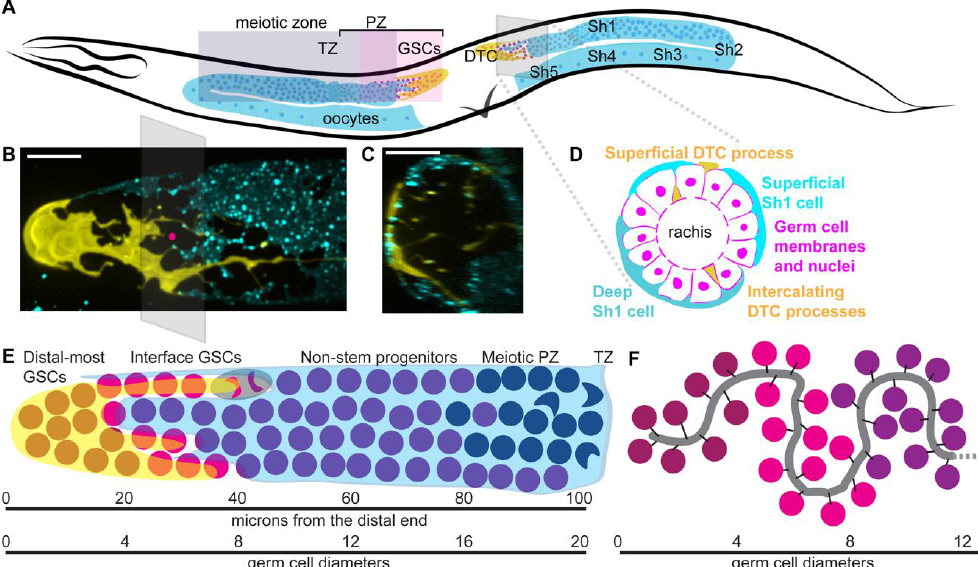
Figure 1. Structure and development of adult hermaphrodite gonad ( A ) Schematic of adult hermaphrodite gonad with distal tip cells (yellow, DTC), sheath cell pairs 1–5 (only superficial cell of each pair shown, cyan); somatic gonad cells are labeled in posterior gonad arm. In the anterior gonad arm, germ cell regionalization is shown in shaded boxes with the distal progenitor zone (PZ) containing germ stem cells (GSCs, pale pink), non-stem progenitor cells (bright pink) and cells in S phase of meiosis I (purple). The transition zone (TZ) is where crescent shaped nuclei of meiotic leptotene/zygotene stage are visible; this is a common visual landmark that can be detected with DAPI staining and does not rely on genetic markers. All meiotic germ cells shaded purple. Oocytes shown in proximal gonad. All germ cell nuclei are magenta. Head to left, dorsal up, vulva (V) at bottom. Gray pane shows angle of cross section shown in ( B ). ( B ) Confocal Z-projection through distal gonad with DTC in yellow (single copy transgene lag-2p::mNeonGreen::PLC dPH ) and Sh1 in cyan ( mKate::inx-8 endogenously tagged protein). Gray pane shows angle of cross section shown in ( C ) and ( D ), with pink dot at center of stack. ( C ) Cross section of ( B ), Z-projection through 10 microns of the distal gonad around pink dot shown in ( B ). ( D ) Schematic of cross section through PZ with germ cells (magenta), DTC processes (yellow) and Sh1 cells (cyan). Note both superficial and deep Sh1 cells pictured in cross section. Scale bars 10 microns. Pictures by K. Gordon, adapted from [10]. ( E ) Sub-regionalization of the germ line. The DTC (yellow) and Sh1 (cyan) compartmentalize the non-meiotic PZ cells. Under the DTC alone (maroon) are germ stem cells (GSCs) that divide symmetrically; at the DTC-Sh1 interface, additional GSCs (magenta) divide asymmetrically; see example cartoon of cell shaded in gray with anaphase chromatin condensations colored by future daughter cell fates; under Sh1 alone are non-stem progenitor cells (purple) may undergo an additional division outside the niche before entering the meiotic cell cycle (navy). Approximate positions relative to distal end shown, with germ cell “rows” depicted roughly to scale, and to scale with micrograph in ( B ). ( F ) Example of convoluted path of rachis after [30], also shown to approximate scale. The interaction between the rachis folds and the Sh cells is not known; the intercalating DTC processes (not shown) follow the path of the rachis [30].